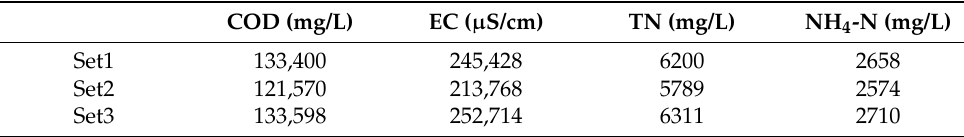
Table 1. Wastewater characteristics.